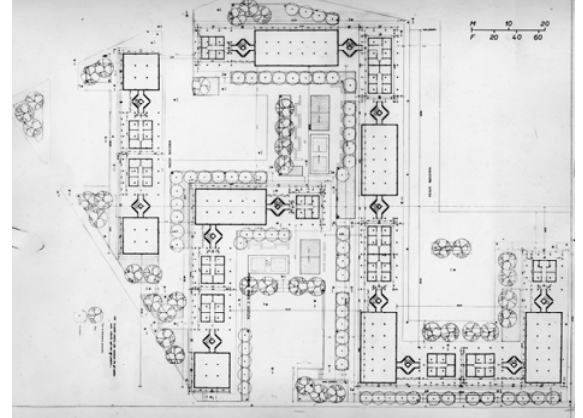
Figure 1. Plan of the project as built